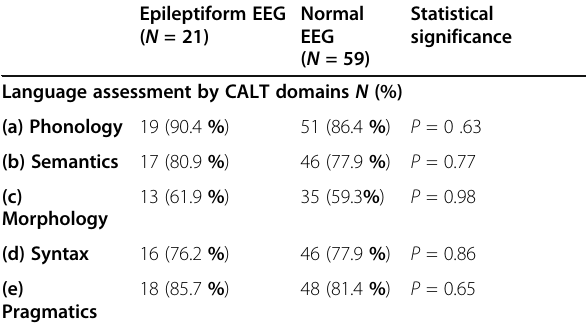
Table 4 Language assessment in epileptic cases compared with cases with normal